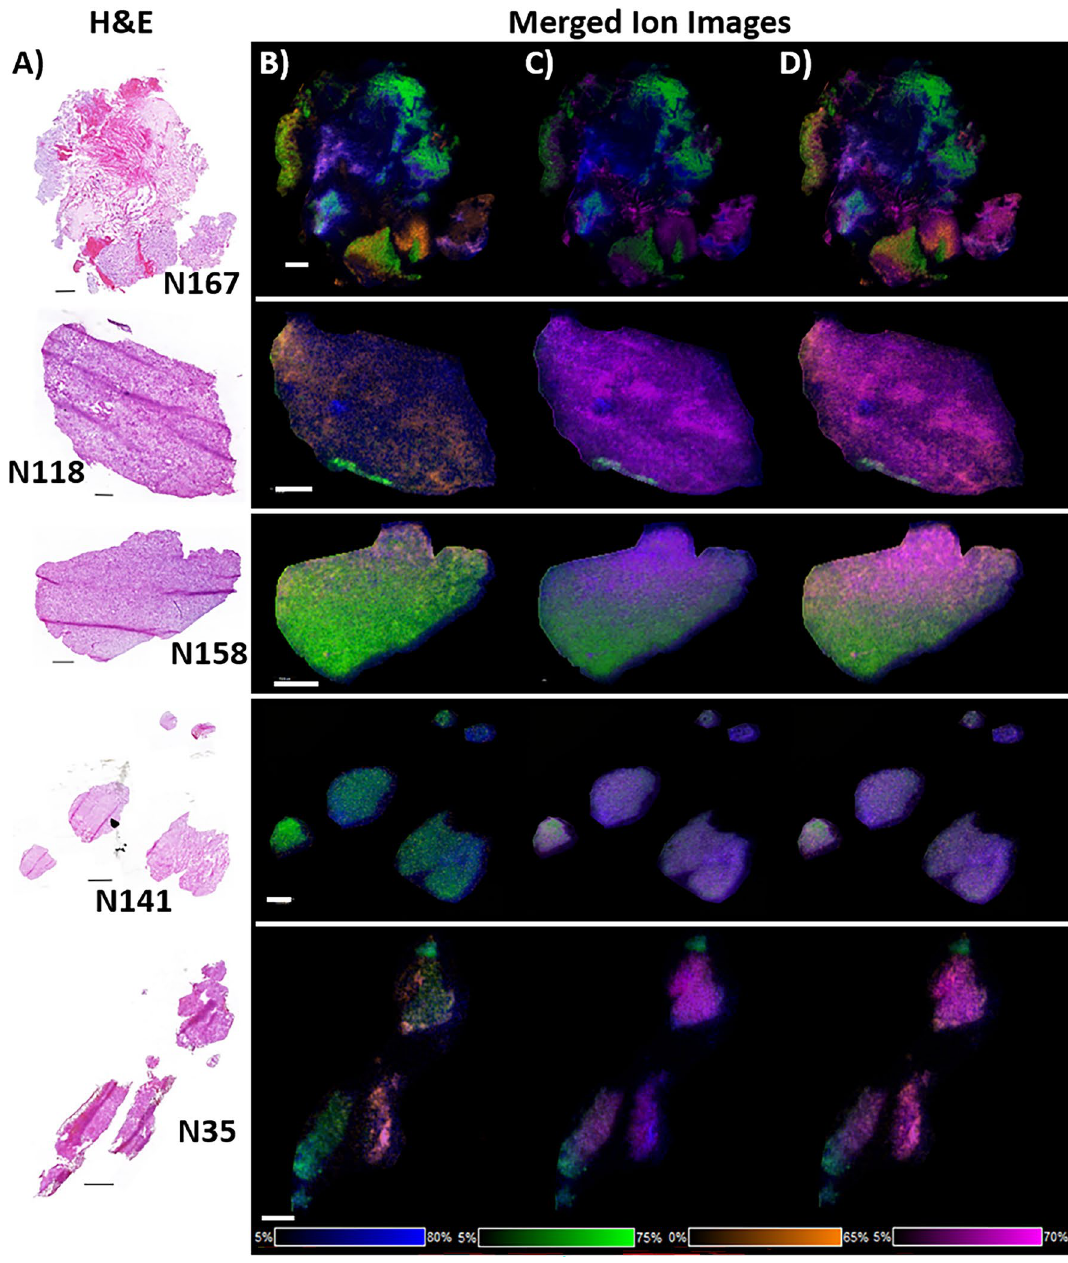
Figure 5. Merged ion images displaying the spatial distribution of multiple lipid classes . ( A ) H&E stained section of each sample is shown in the left panel. ( B ) Merged MS images of GD3(36:1) at m/ z 1470.830 in displayed using orange, C1P(34:1) at m/z 616.471 in blue, and ST(42:2) at m/z 888.624 in green. ( C ) Merged MS images of PI(38:3) at m/ z 887.562 is shown in pink, C1P(34:1) at m/z 616.471 in blue and ST(42:2) at m/z 888.624 in green. ( D ) Merged MS images of GD3(36:1) in orange, PI(38:3) in pink, C1P(34:1) in blue and ST(42:2) in green. Images were acquired at 30 µm pixel resolution from 5 µm thick sections. Scale bars are 1